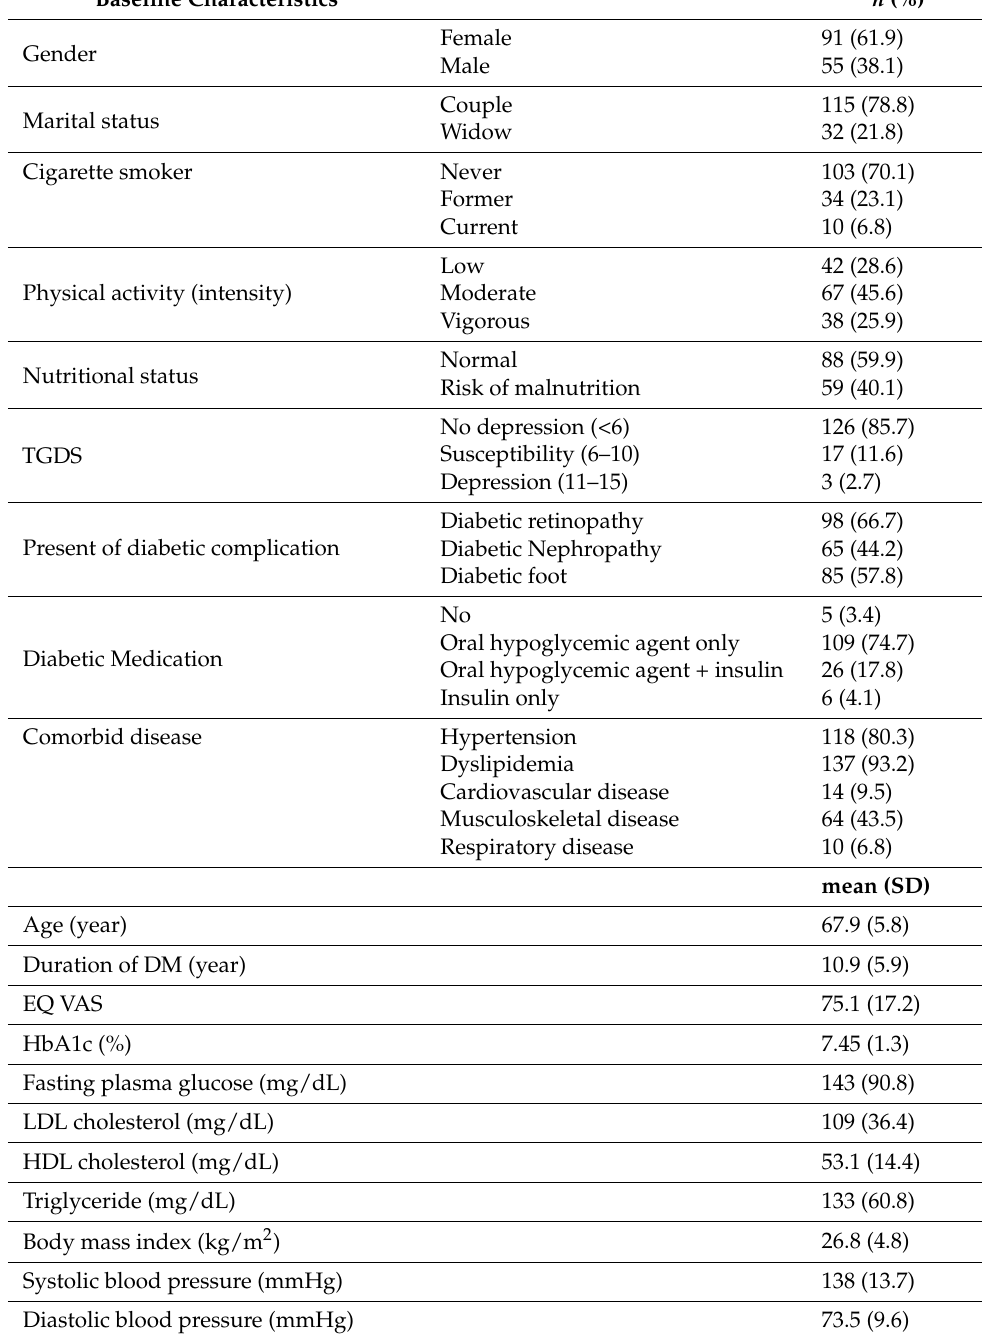
Table 1. Baseline demographic data and clinical characteristic of participants at first visit